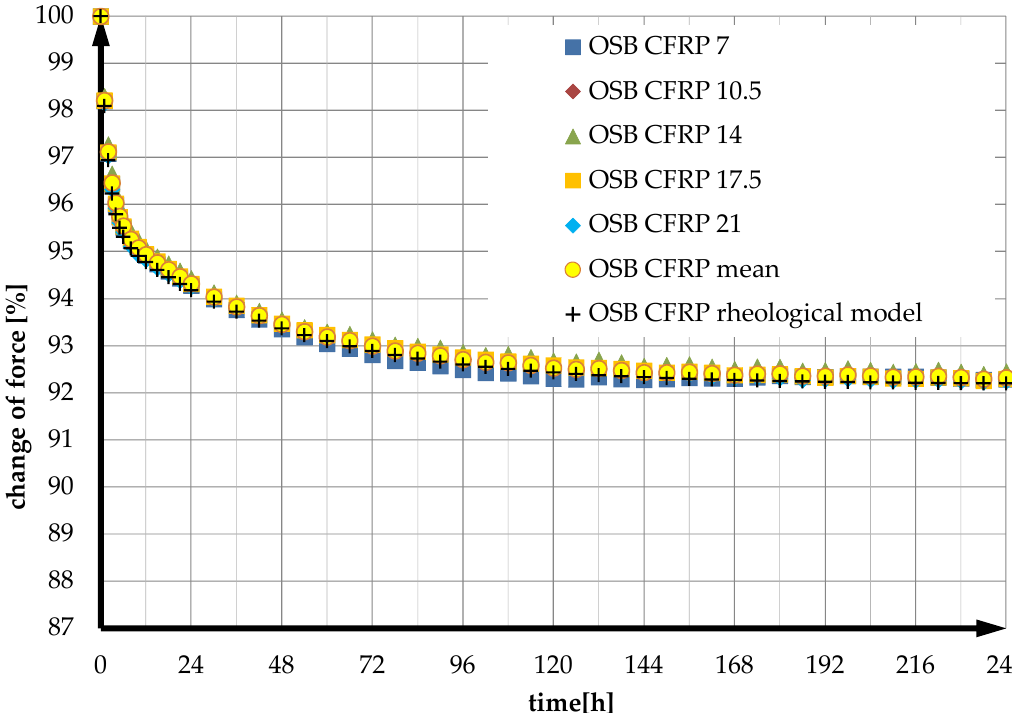
Figure 4. Experimental relaxation functions of OSB beams reinforced with CFRP tape, mean function, and theoretical model.